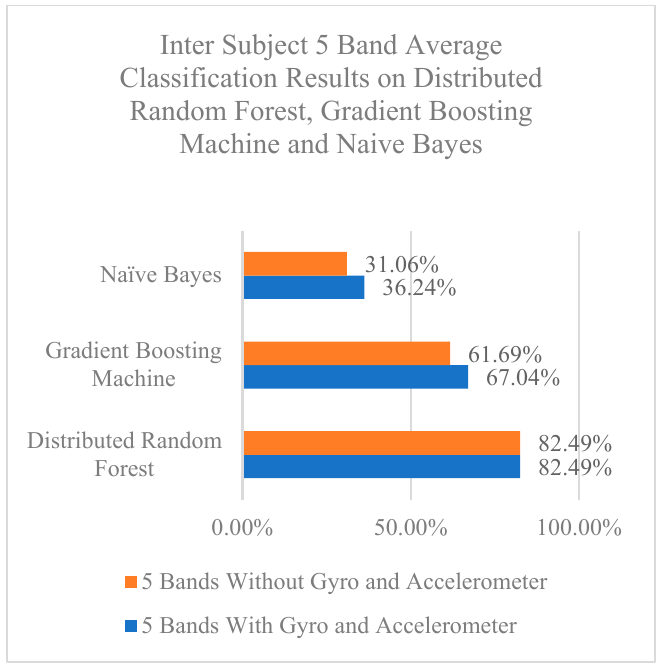
Figure 8. Brainwave and inertial sensing emotion classification result from DRF, GBM, and NB. Using the training model achieved from earlier results, the next step was to develop a live emotion prediction system using the four-class classification approach together with the trained machine model as shown in Figure 9. The model used for this live emotion prediction system was based on DRF obtained from the previous classification experiment. emotion classification accuracy obtained was from the scared emotion at 76.25% and the bored emotion at 72.50%. Both the scared and bored emotions are located in the low arousal space of the AVS model.